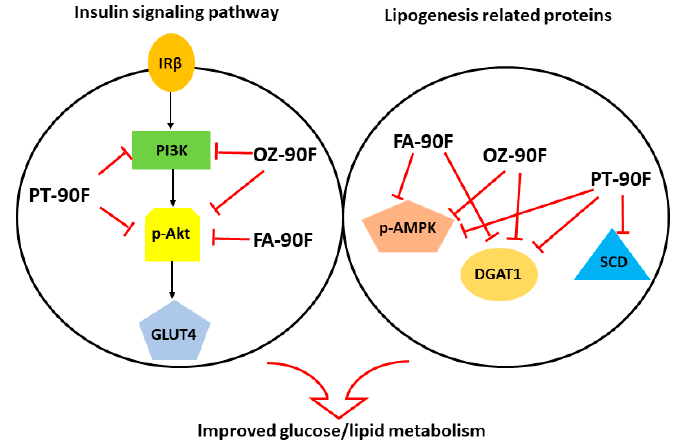
Figure 9. Potential pathway for enriched flours in regulating glucose/lipid metabolism.